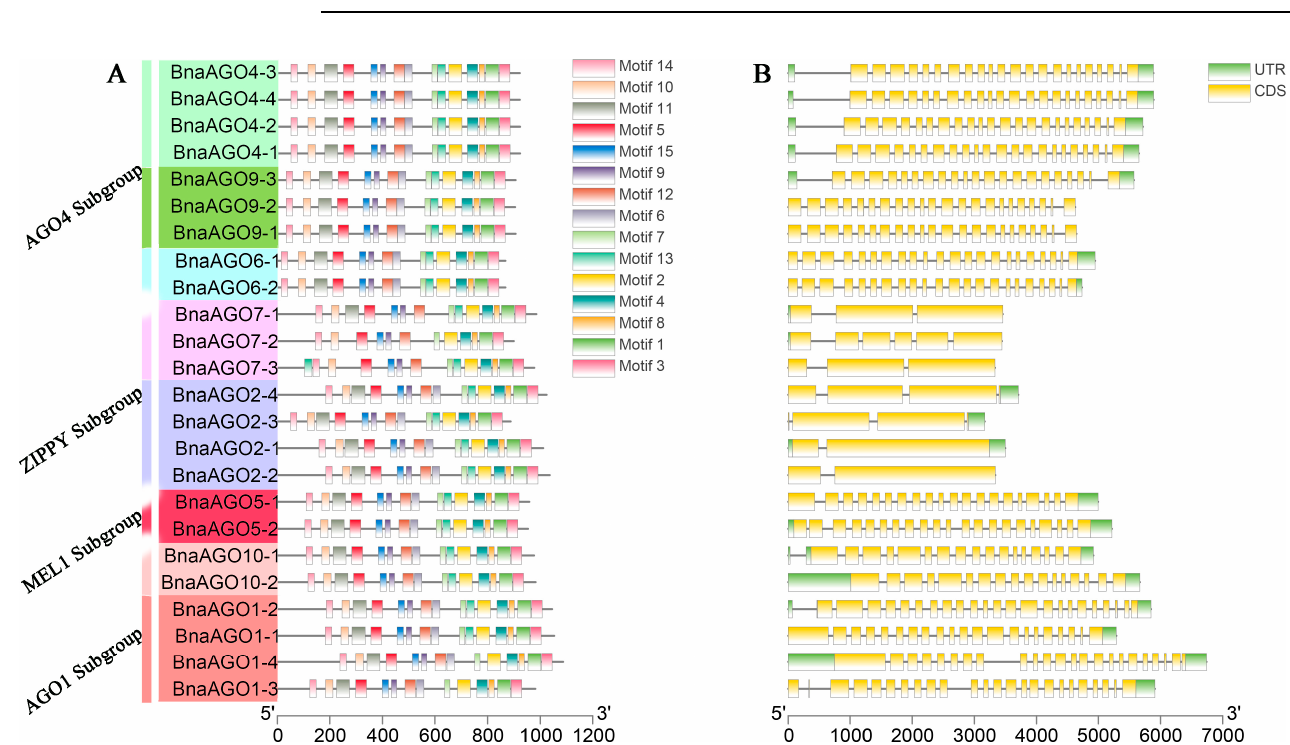
Figure 3. The conserve motif ( A ) and gene structure ( B ) analysis among the 24 BnAGOs .